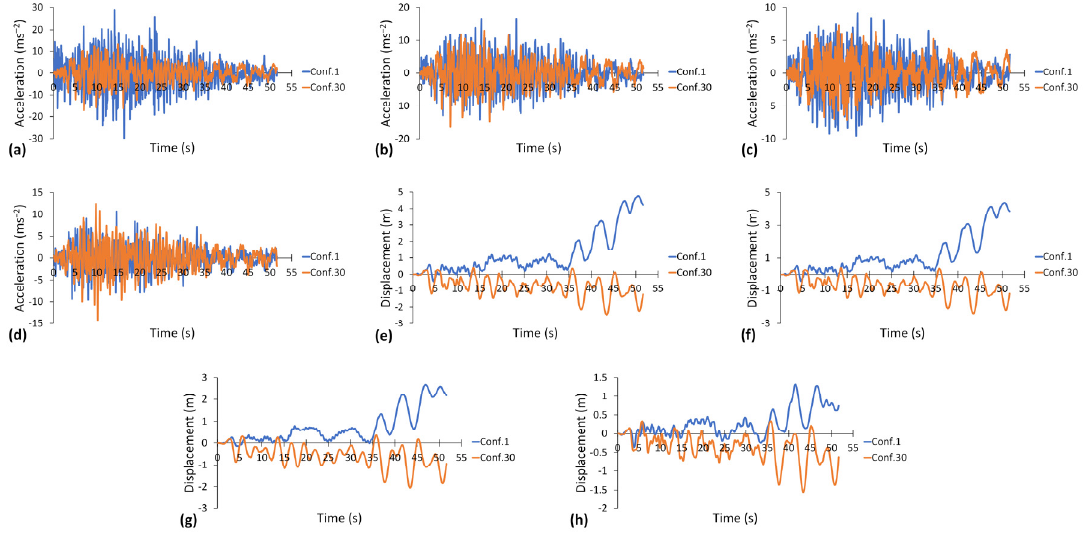
Figure 18. Structural response time histories under Taft earthquake: ( a ) acceleration at the top of the structure, ( b ) acceleration at the top of the fourth substructure, ( c ) acceleration at the top of the third substructure, ( d ) acceleration at the top of the second substructure, ( e ) displacement at the top of the structure, ( f ) displacement at the top of the fourth substructure, ( g ) displacement at the top of the third substructure, and ( h ) displacement at the top of the second substructure.